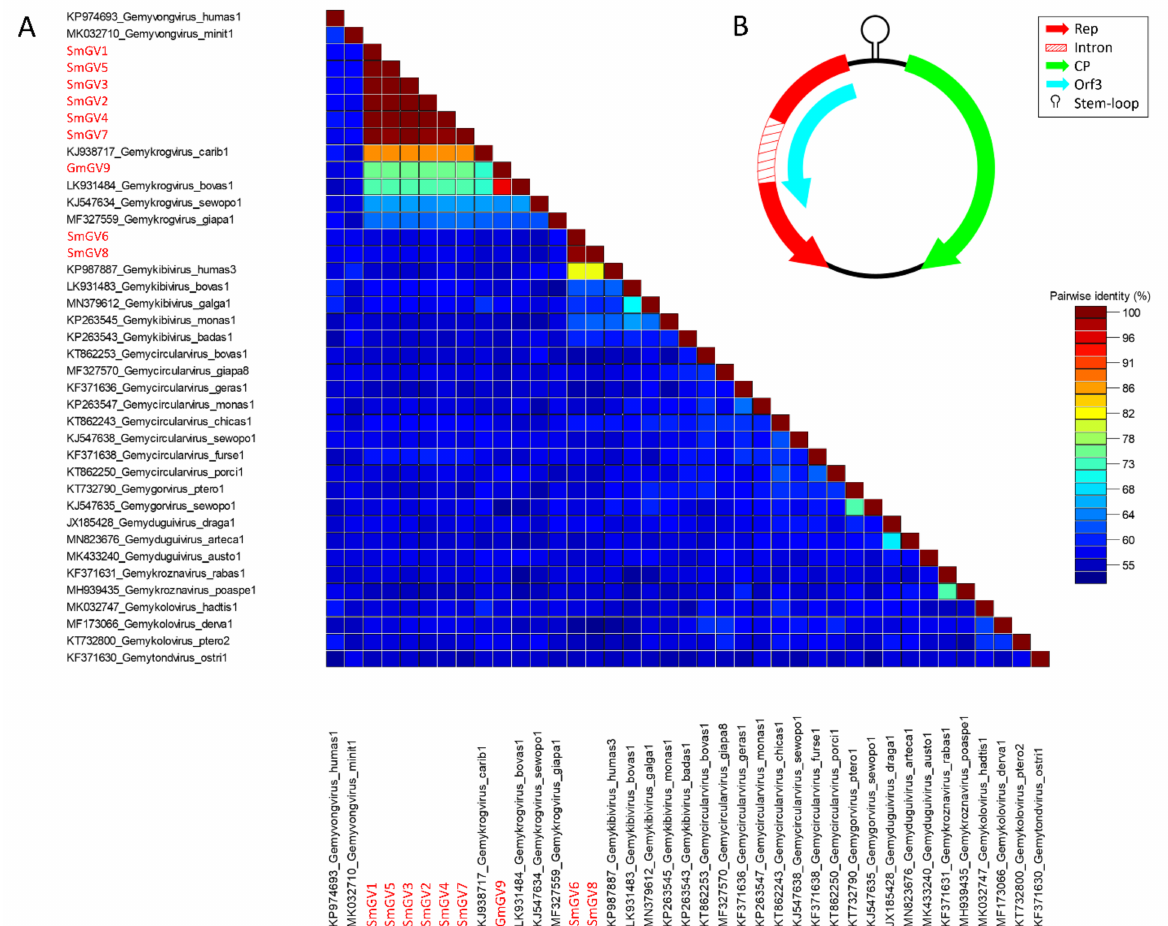
Figure 1. ( A ) Genome-wide pairwise nucleotide similarity score matrix including full-length genomoviruses from this study and representative members from nine genera of the family Genomoviridae . Sequences from this study are highlighted in red. ( B ) Schematic genome organization of the herein identified genomoviral sequences shows at least two major open reading frames and a stem-loop structure in the intergenic